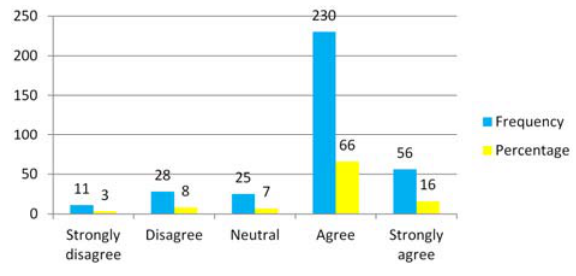
Fig. 1. Entrepreneurial spirit of the